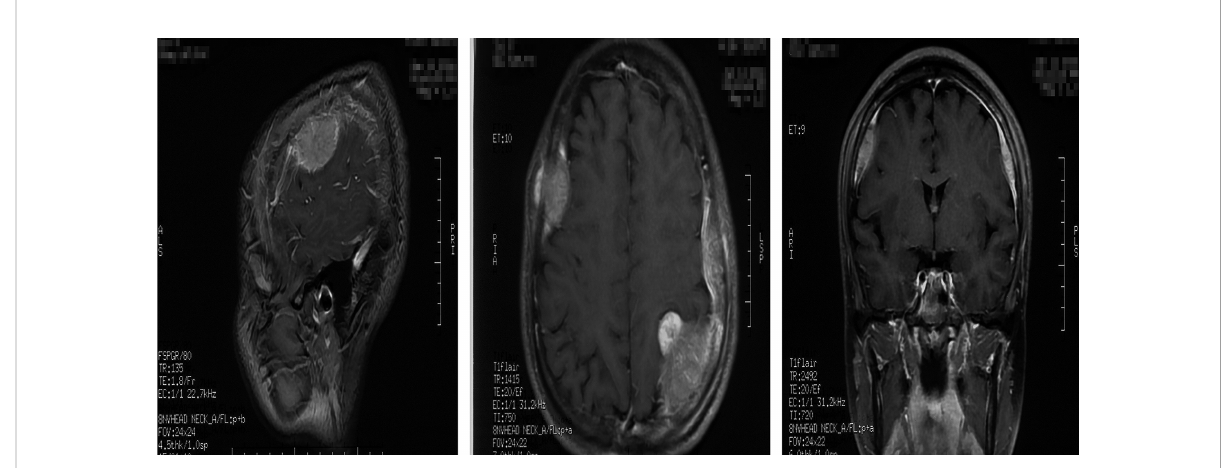
FIGURE 4 MRI of the brain showed the metastases of the scalp, skull, and meninges.